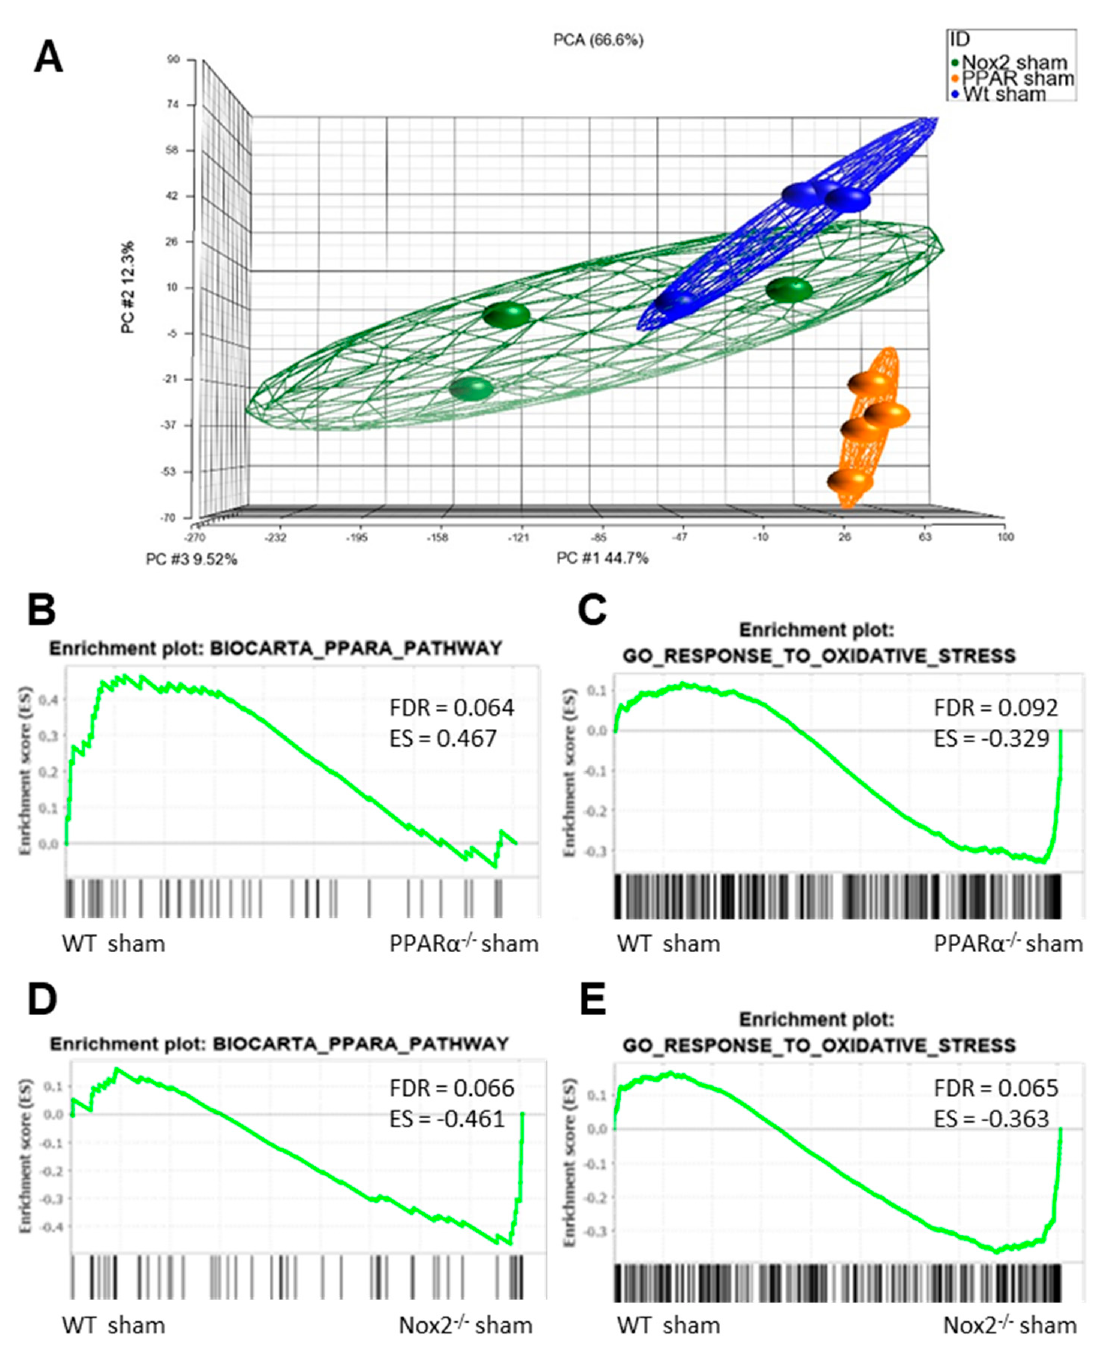
Figure 5. Nox2 and PPAR α deletion result in significant transcriptomic alterations in pathways mediating PPAR α and oxidative stress signalling in mouse cardiac tissue. ( A ) Principal component analysis demonstrating altered clustering of transcript expression in WT, PPAR α − / − , and Nox2 − / − sham hearts. GSEA plots depicting cardiac transcript expression in ( B ) Biocarta PPAR α pathway and ( C ) GO response to oxidative stress in WT sham vs. PPAR α − / − sham, and ( D ) Biocarta PPAR α pathway and ( E ) GO response to oxidative stress in WT sham vs. Nox2 − / − sham. N = 3 − 4.